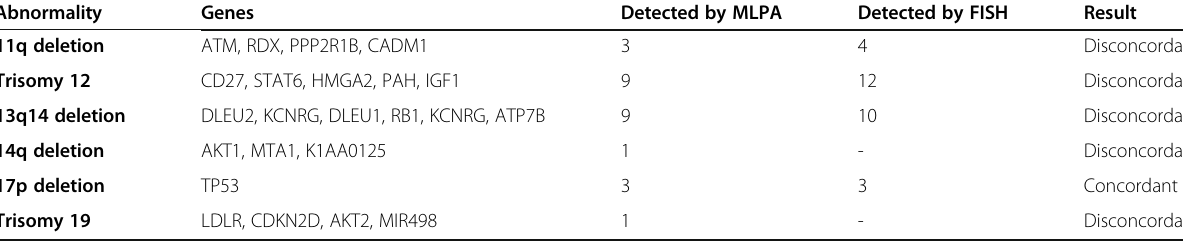
Table 2 Frequencies of the abnormalities detected by MLPA and FISH Abnormality Genes